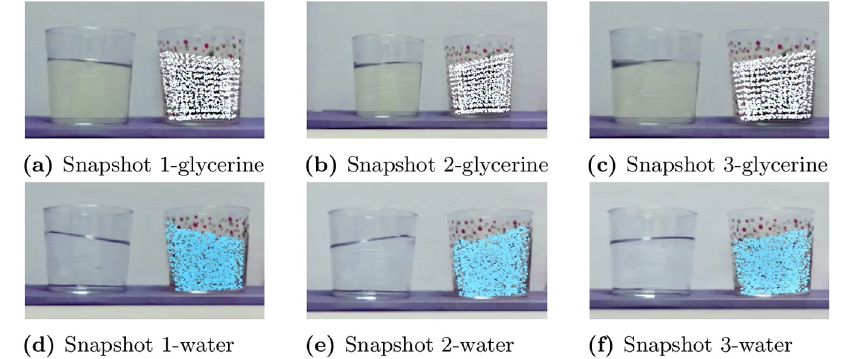
Fig 8. Snapshots employed for comparison between the real liquid and the digital twin. The free surface reconstruction has been evaluated to compute the error.